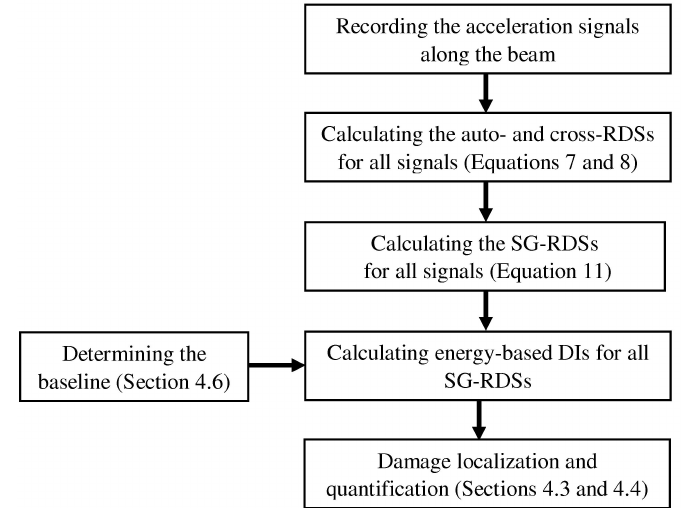
Figure 1. General flowchart of the proposed damage detection